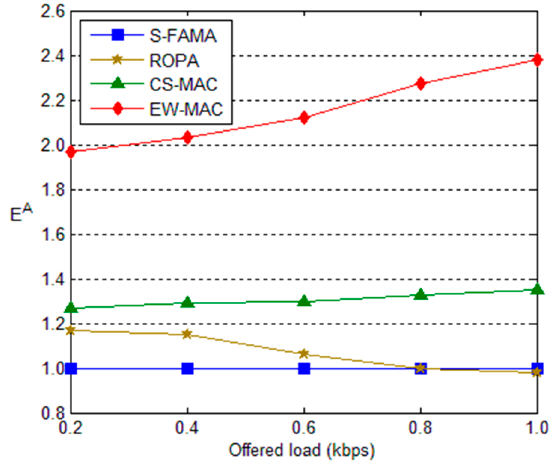
Figure 11. Efficiency indexes for different offered loads.